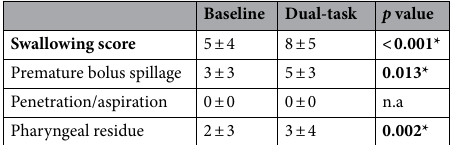
Table 2. Comparison of the swallowing score and its subdomains between single-task and motor dual-task conditions. Bold value indicates the p < 0.05. Mean value ± SD of the swallowing score and its subdomains during single task condition and during motor dual-task condition and the p value of the post-hoc comparison. n.a . not